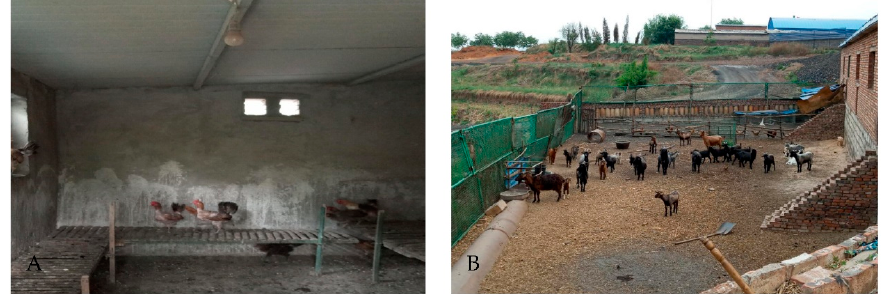
Figure 2. Photographs of representative insect breeding grounds and collected sandflies. Note: ( A ) Chicken pen. ( B ) Sheep pen.